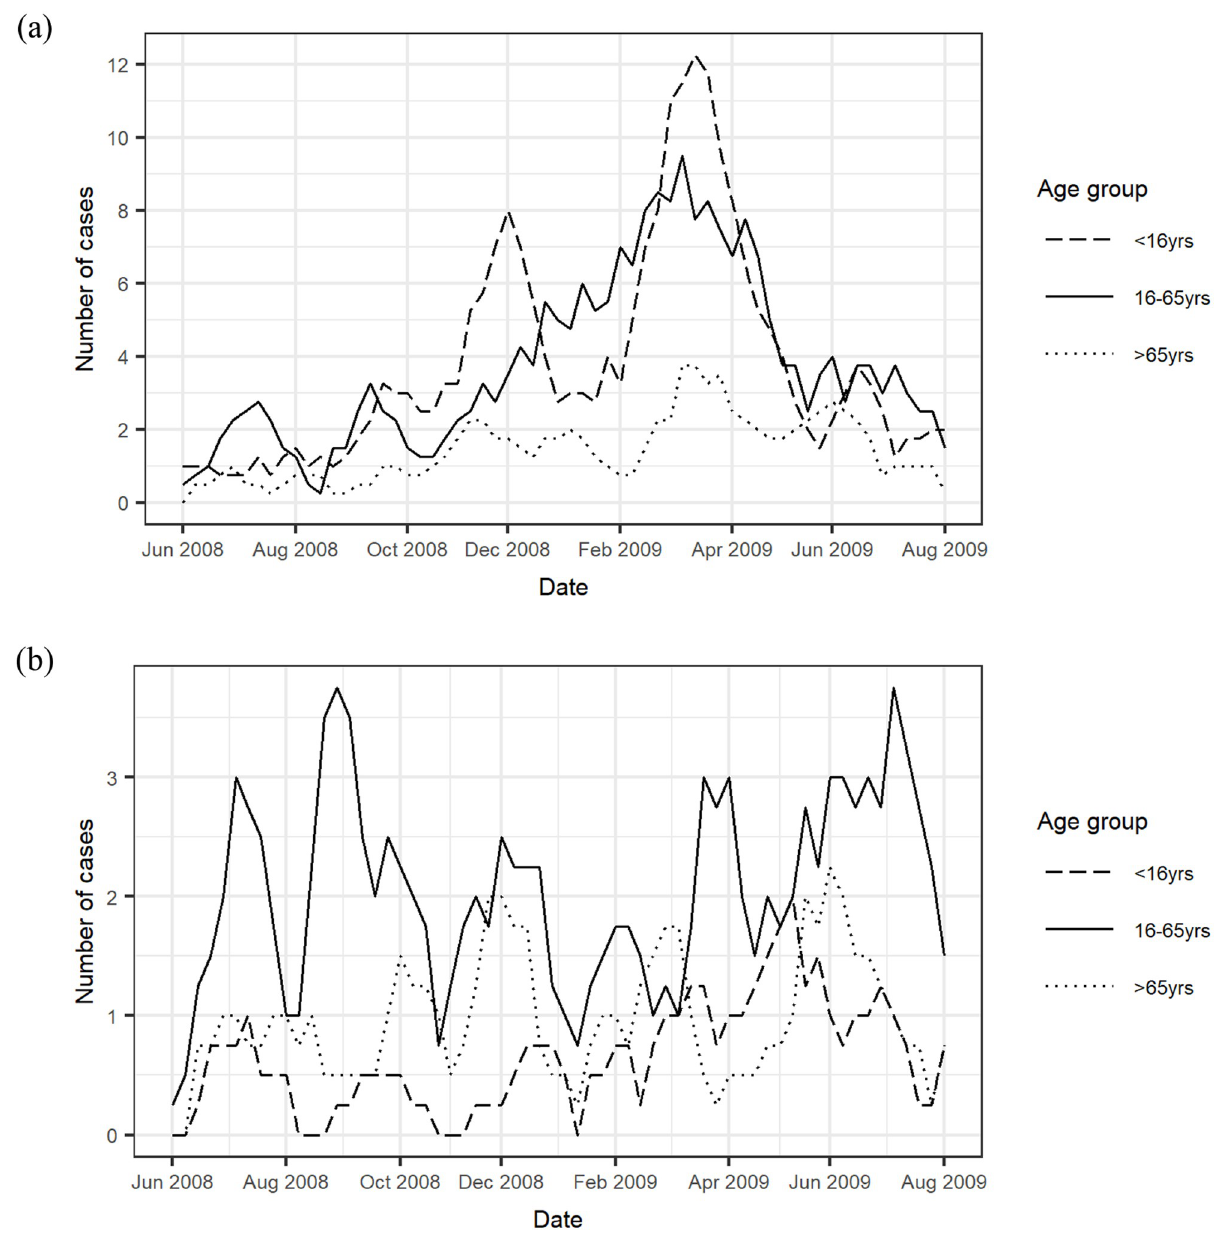
Fig 1. Time trends for IID, by age, for a) viral IID and b) bacterial IID, based on 4-week rolling average case numbers.